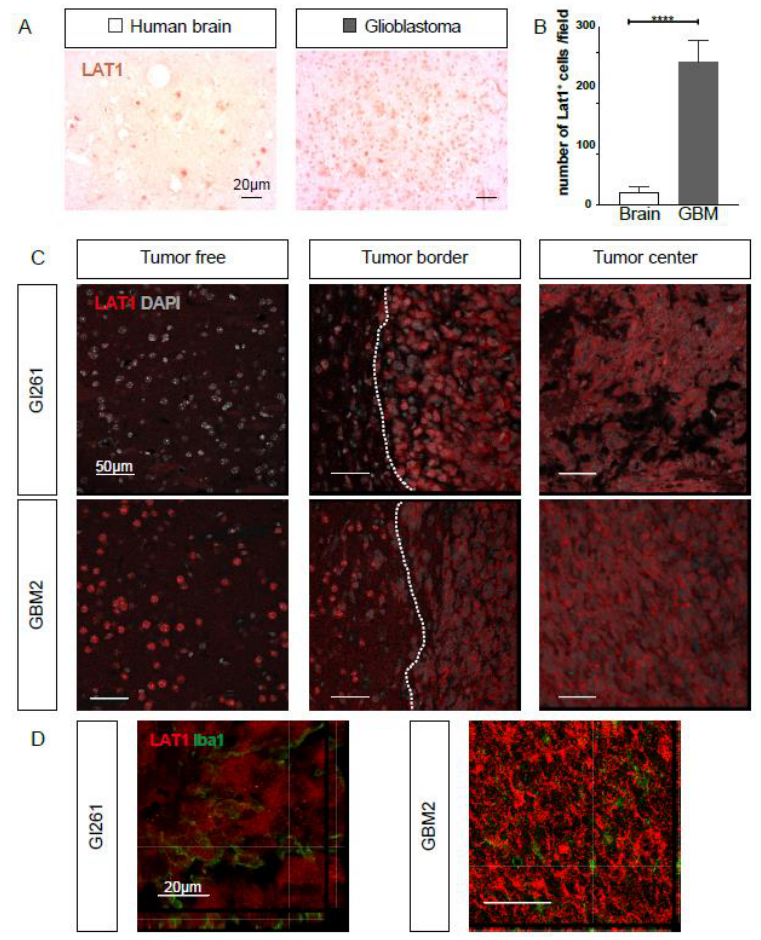
Figure 5. Amino acid transporter light chain L system (LAT1) expression is increased in human and murine GBM. ( A ) Immunohistochemistry of epilepsy ( n = 4) and GBM patient samples ( n = 4) was